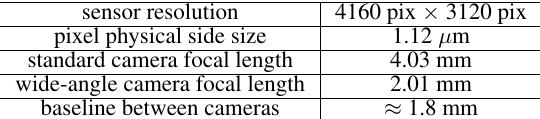
Figure 3. Acquisitions with Pico Zense DCAM710 on a